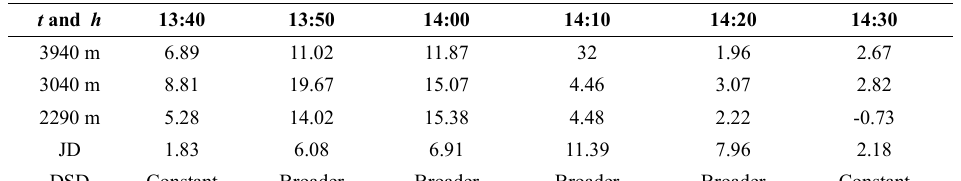
Table 2. Rain rates (dBR) at several heights (h) and times (t) and outline properties of the DSD process from upper to ground level